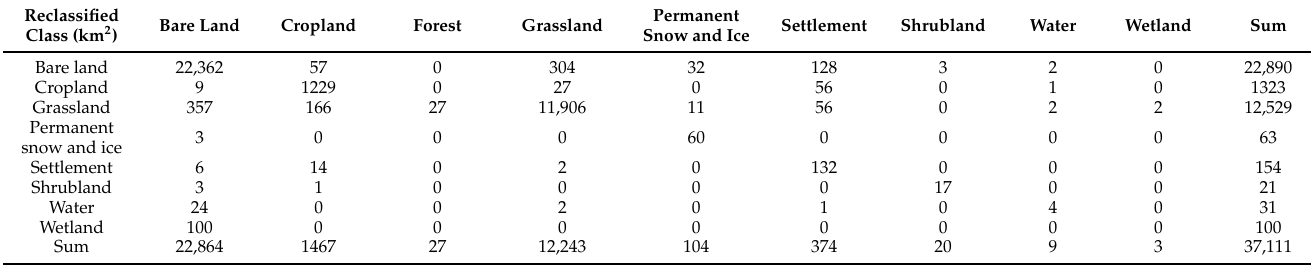
Table A4. Land use/land cover area transfer matrix from the year 2010 to 2020 in the Turpan